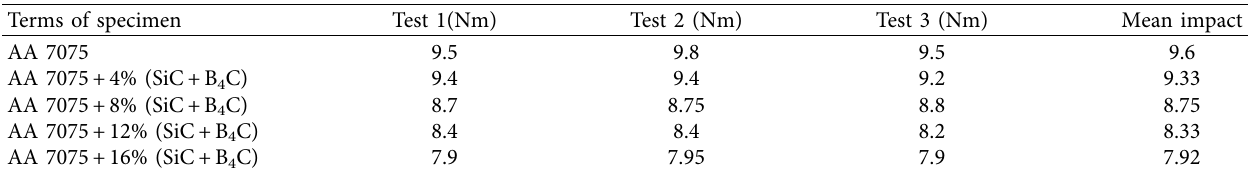
Table 5: Impact tests results.